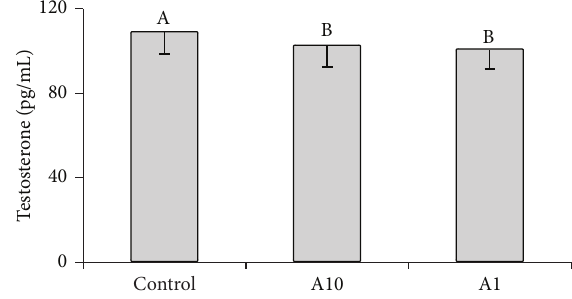
Figure 5: The effect of adiponectin (10 𝜇 g/mL-A10 and 1 𝜇 g/mL- A1) on basal testosterone secretion by cultured theca interna cells collected on days 17–19 of the oestrous cycle. Bars with different superscripts are significantly different ( 𝑃 < 0.05 ). Results are means ± S.E.M. of five